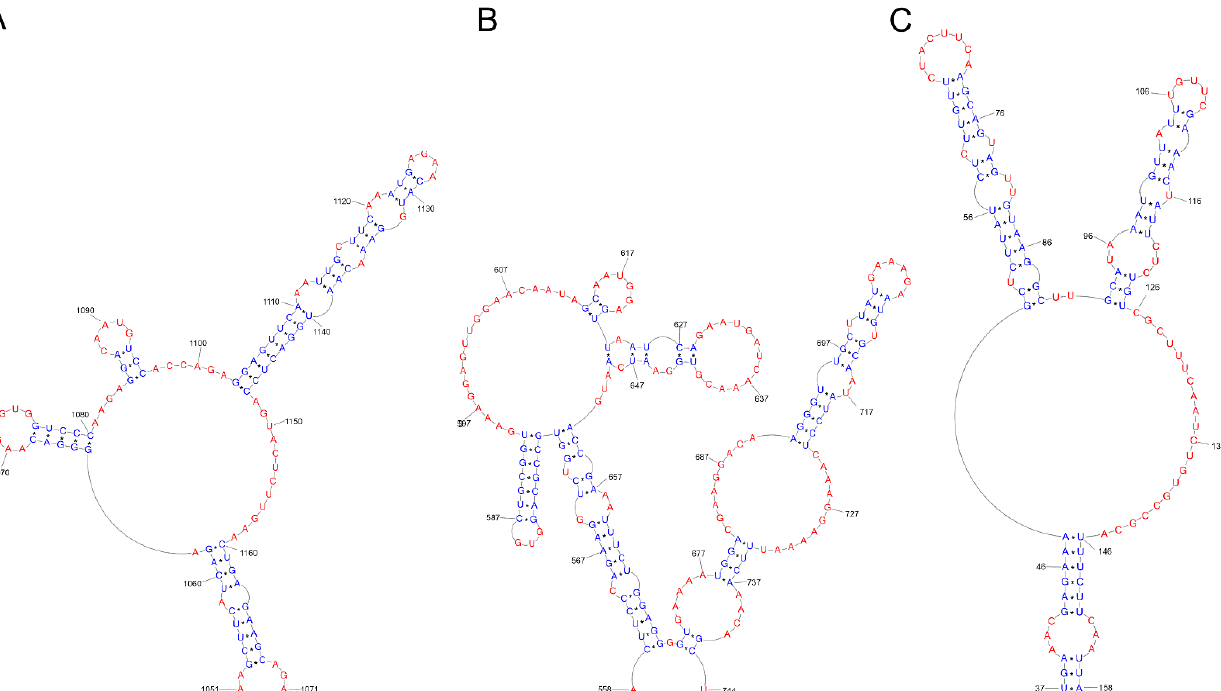
Figure 6. Secondary structure motifs of influenza A virus RNA that appeared to be a good target for inhibitors of virus propagation. ( A ) — M121 motif; ( B ) — selected motif of mRNA5; ( C ) — selected motif of vRNA8. Blue and red letter colors mark paired and unpaired nucleotides, respectively.